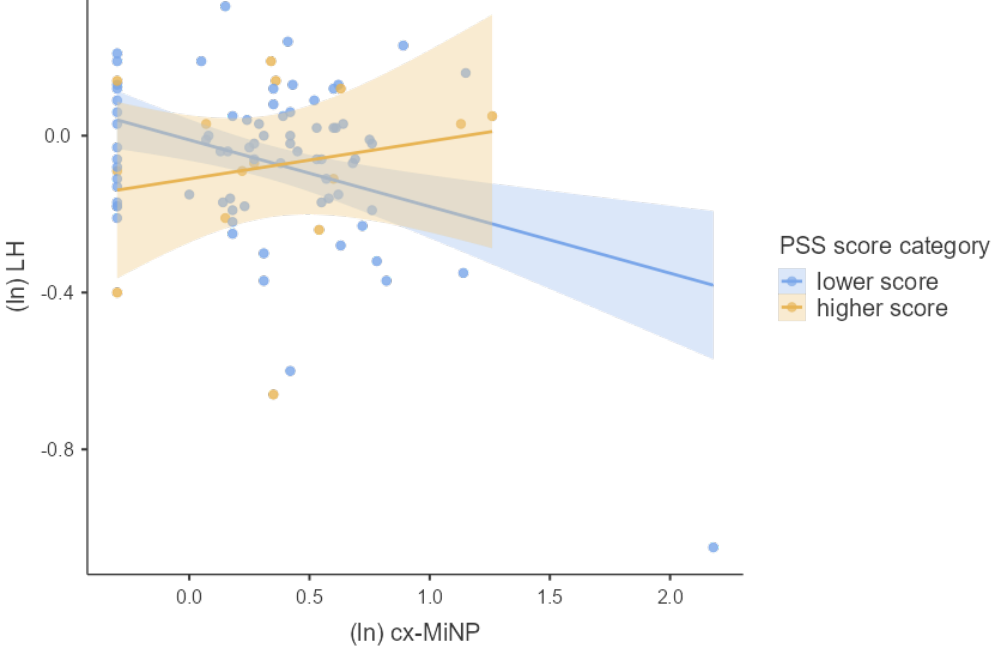
Figure 4. The associations between the concentrations of LH and cx − MiNP based on the PSS score category stratification; Legend: cx-MiNP—mono(carboxy − methyl − heptyl) phthalate, ln—log transformation, LH—luteinizing hormone, PSS—perceived stress scale.